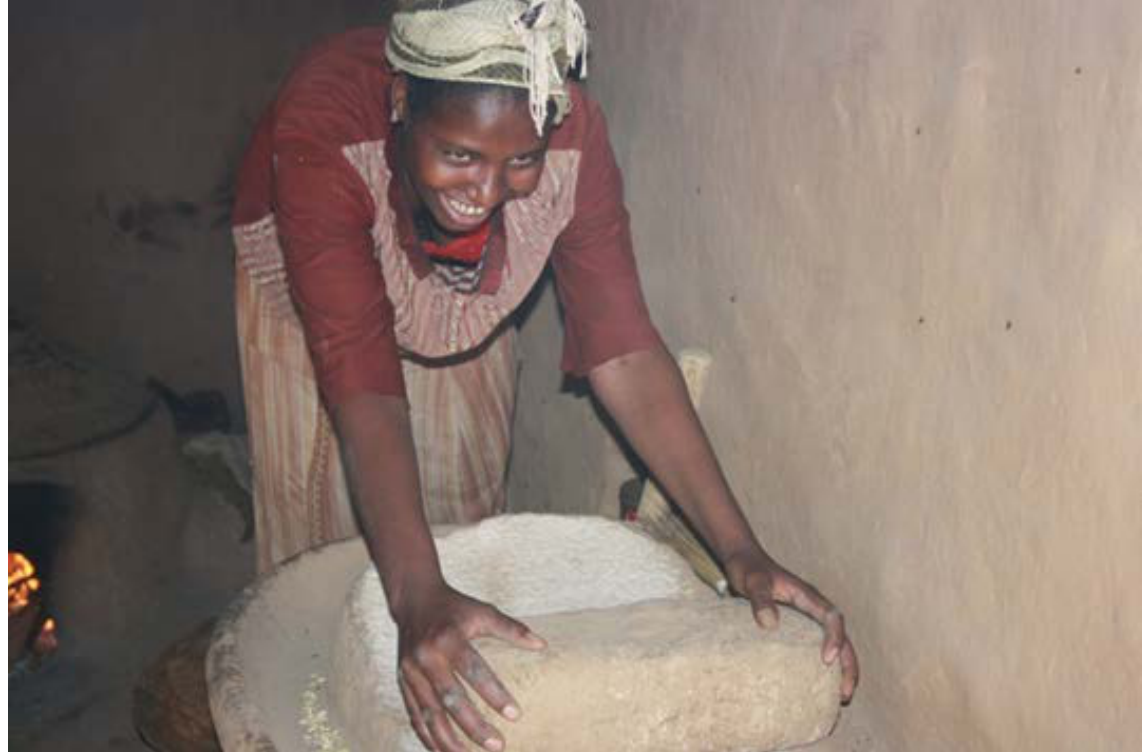
Figure 1. Northeastern Tigrai woman grinding flour with a mațhan (quern) and madit